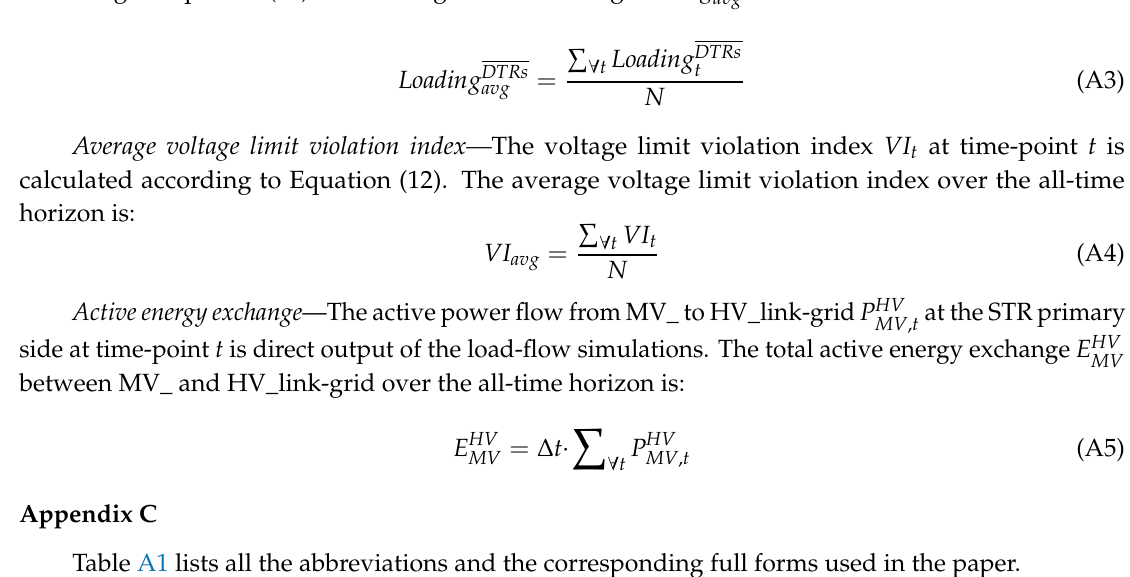
Table A1 lists all the abbreviations and the corresponding full forms used in the paper. Table A1. Abbreviations and corresponding full